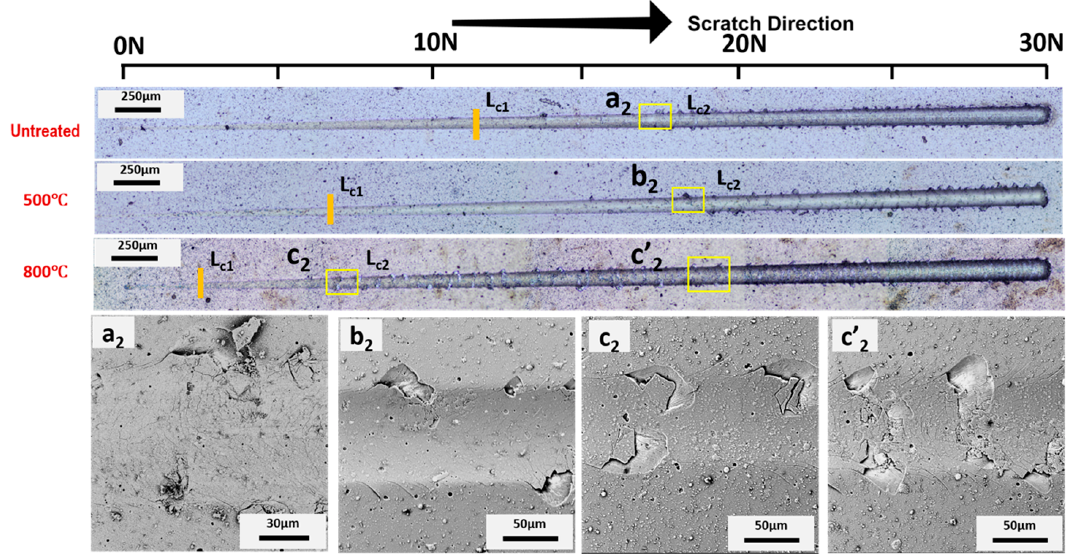
Figure 6. Adhesion optical profile of failures after microscratch tests of the AlCrSiN/Inconel sample. First ( L c1 ) and second ( L c2 ) critical loads are indicated. SEM magnification of selected areas (a 2 , b 2 , c 2 and c’ 2 ) are also presented.